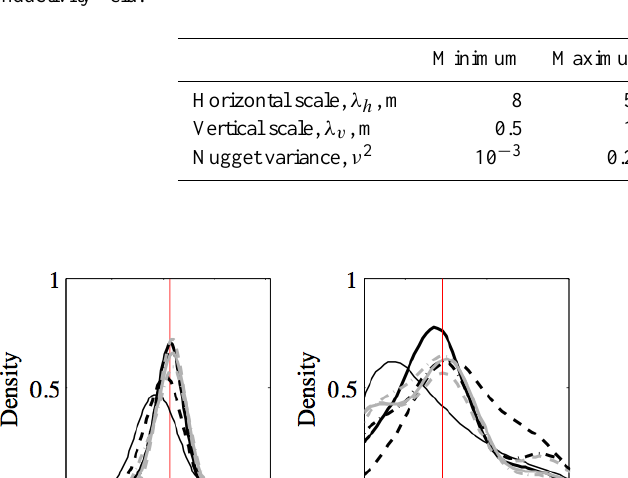
Table 2. The lower and upper bounds of the prior distribution for the horizontal scale, vertical scale and nugget variance of the 3-D hydraulic conductivity field.